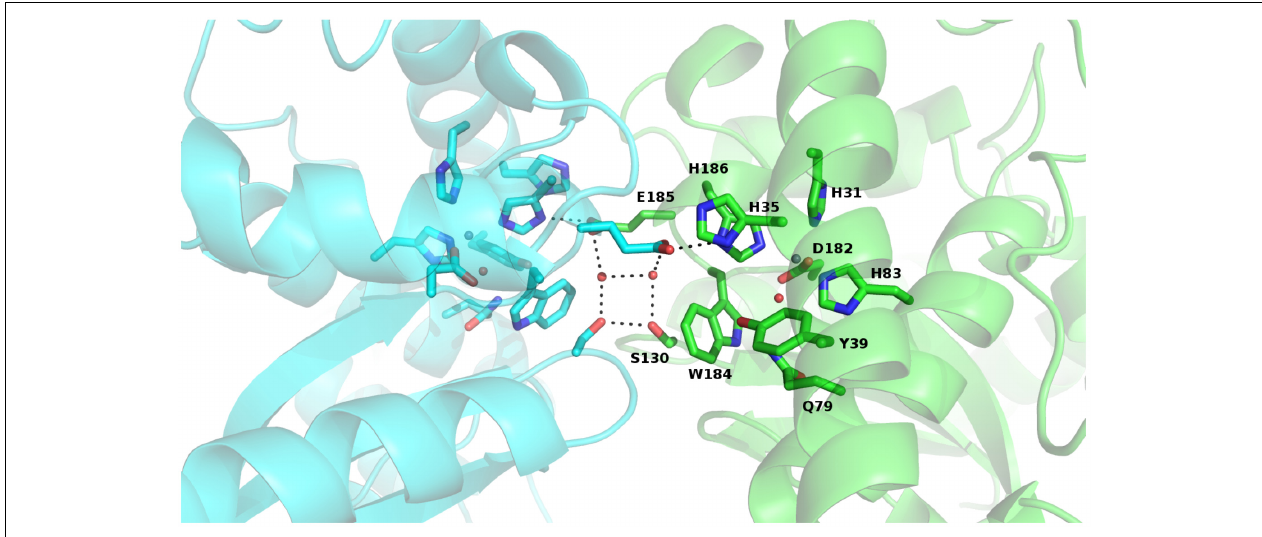
FIGURE 7 | View of the conserved interactions between both monomers of PAP9 and observed in FeSODs, with each monomer of PAP9 in a different color. The residues involved are drawn in sticks, the hydrogen bonds are represented in dark dashed lines and the water molecules are shown as spheres. The zinc ion is drawn as gray sphere. The β -strands are drawn in arrows and the α -helices are represented in